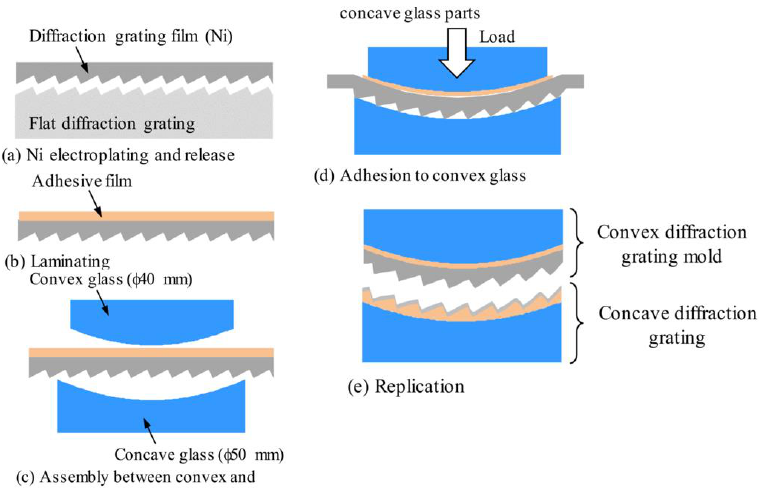
Figure 8. Process flow diagram for making convex and concave gratings by 2D bending method [81].